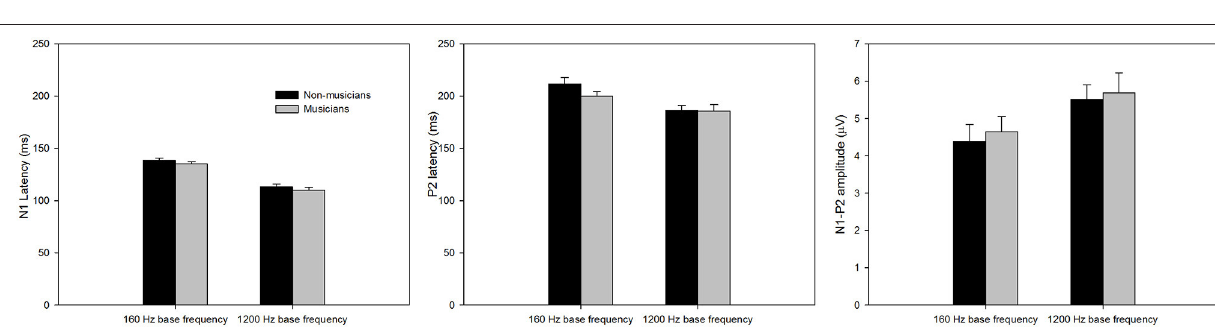
Comparison between the Onset LAEP and the